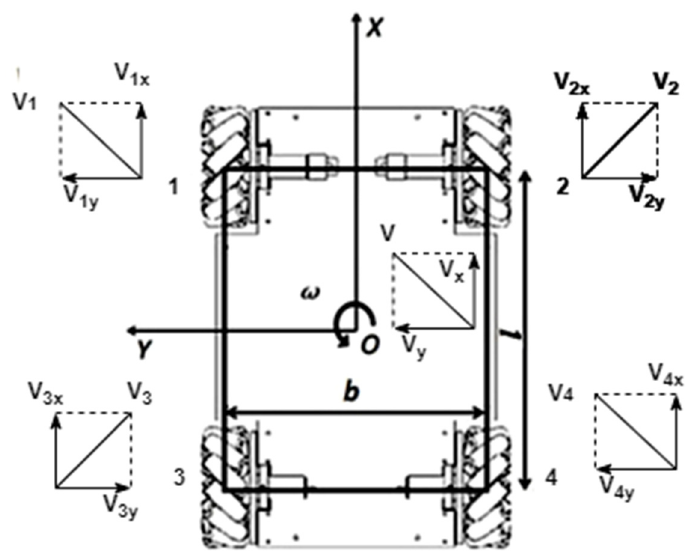
Figure 2. A robotic system with omnidirectional chassis.